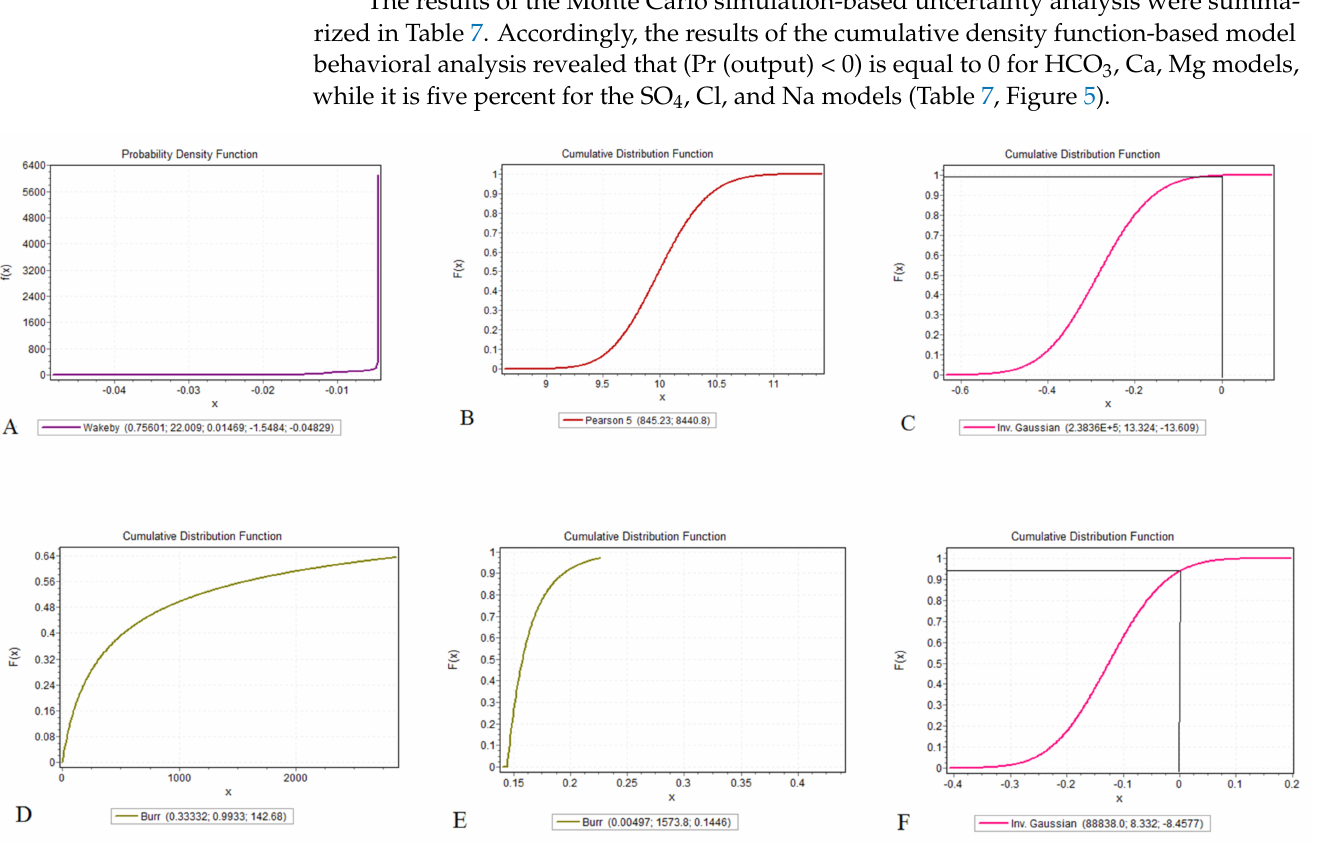
Figure 5. The cumulative density function for the simulated regression models ( A ): SO 4 , ( B ): HCO 3